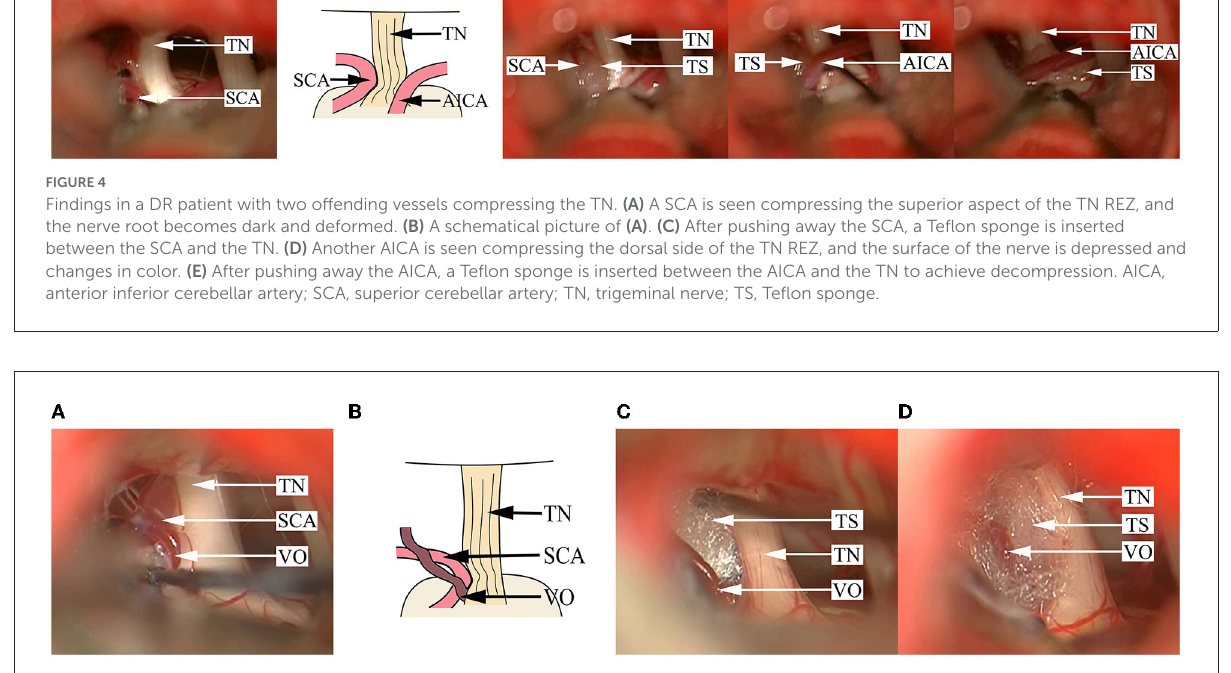
FIGURE5 Findings in a DR patient whose OA and vein simultaneously compress the TN REZ. (A) A branch of the petrosal vein and an SCA are seen compressing the superior aspect of the TN REZ. (B) A schematical picture of (A) . (C) After pushing away the SCA, the Teflon sponge is inserted between the TN. (D) Decompression is implemented by inserting the Teflon sponge between the vein participating in NVC and the TN root. SCA, superior cerebellar artery; TN, trigeminal nerve; TS, Teflon sponge; VO, venous